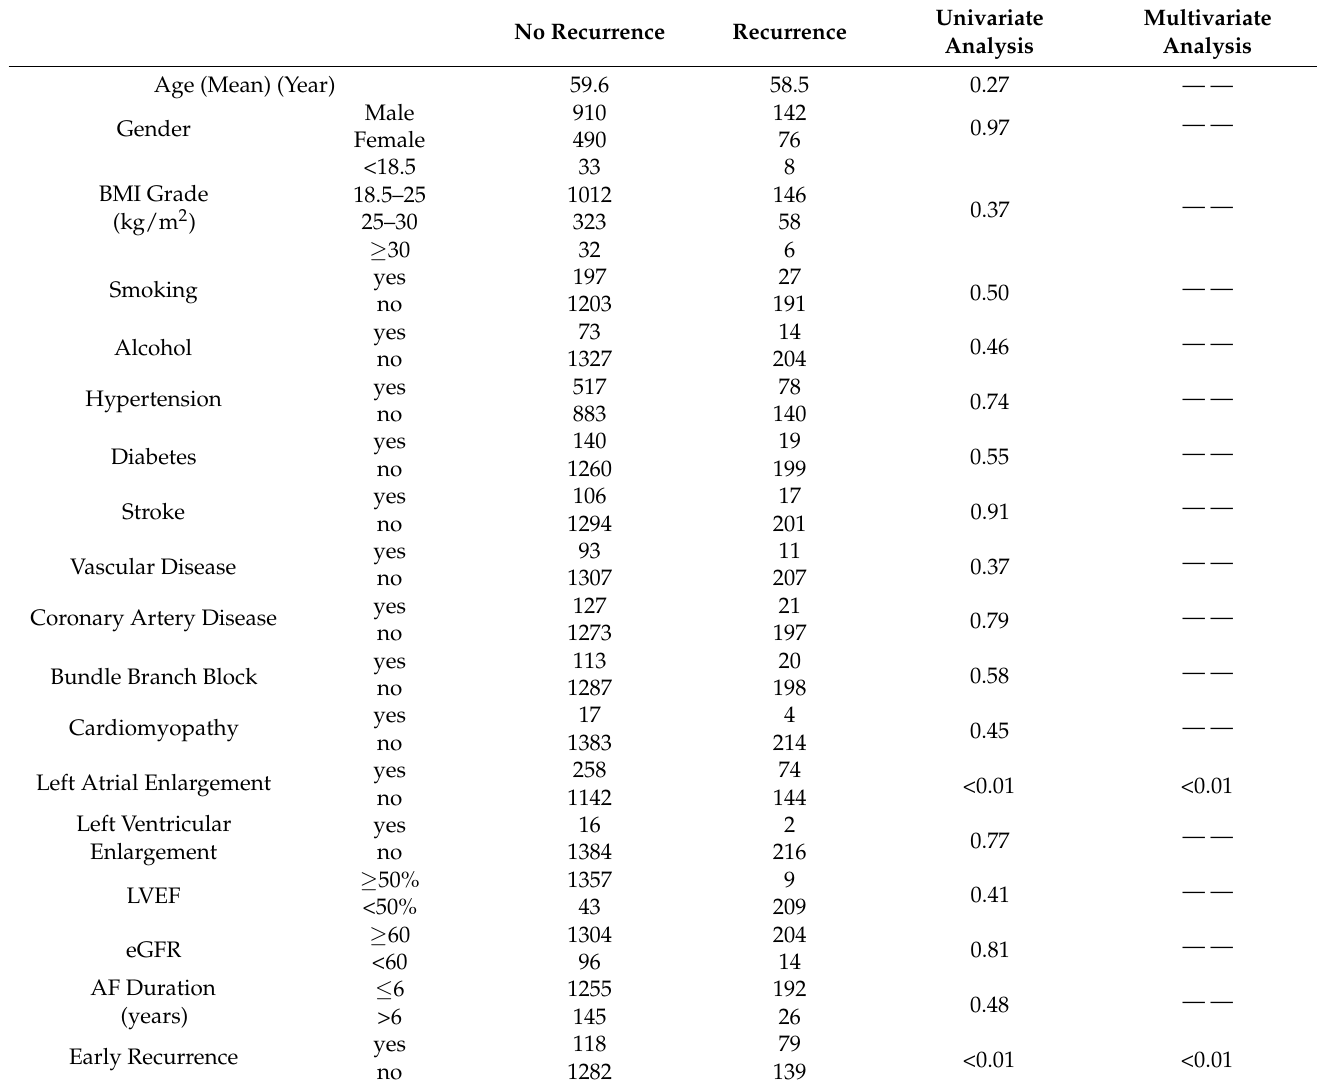
Table 1. Clinical Characteristics of